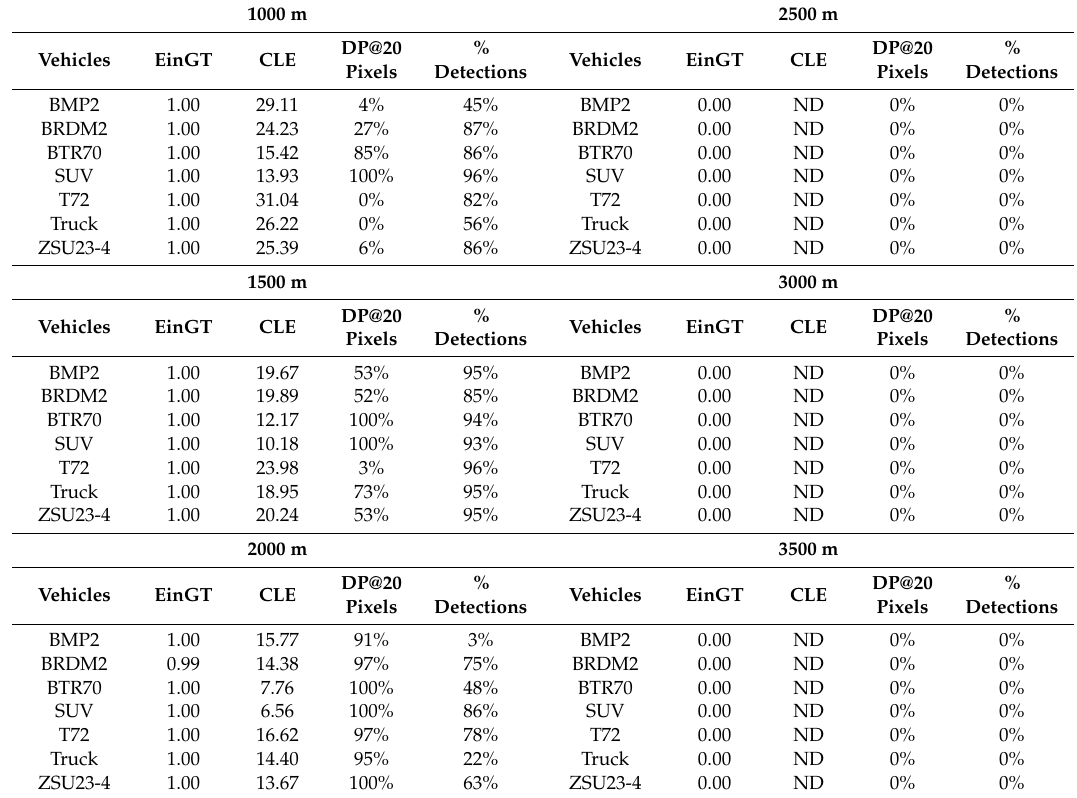
Table A9. Tracking metrics for PCE 50 (MWIR nighttime). ND means no